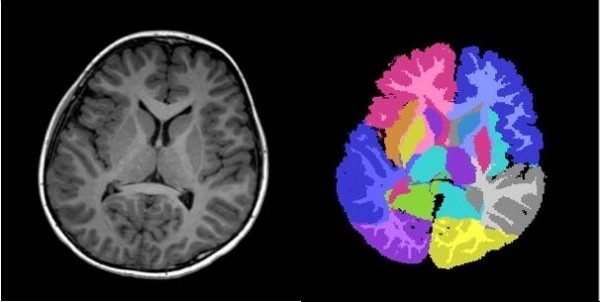
Demonstration of T1-weighted MRI tissue segmentation combined with parcellation of a 9-year-old child’s brain. Axial slice on the left; corresponding combined tissue segmentation/parcellation on the right.